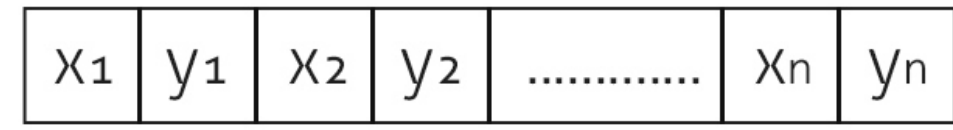
Figure 4. Chromosome